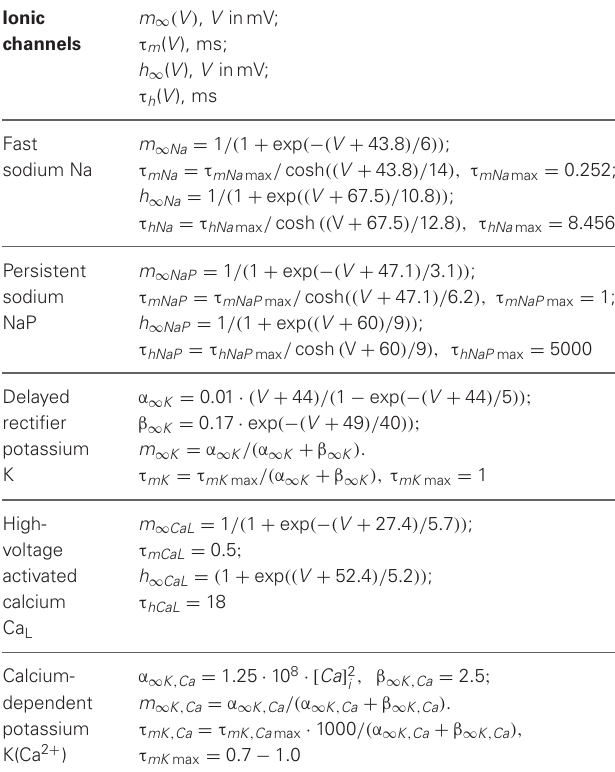
Table A1 | Steady state activation and inactivation variables and time constants for different ionic channels.